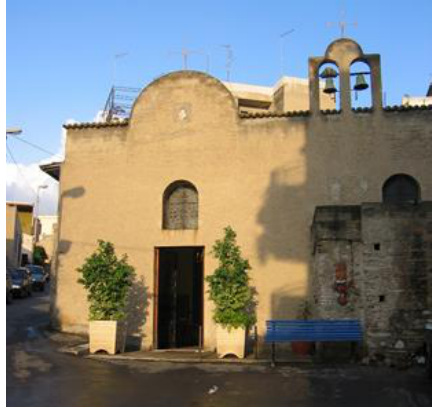
Figure 1. Madonna dei Poveri’s Church (chiesa Pepe), Reggio